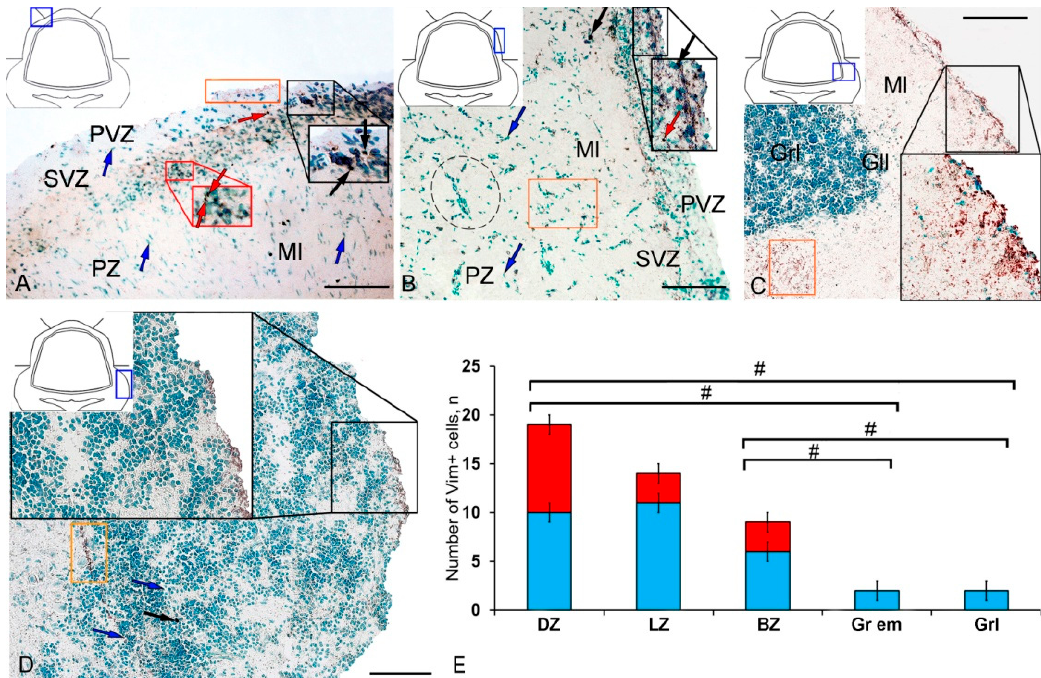
Figure 1. Distribution of vimentin in the intact cerebellum of juvenile masu salmon, Oncorhynchus masou . ( A ) Dorsal zone: Vim + cells 1 type (red arrows); Vim − cells 2 type (black arrows), aggregation of Vim + cells in the periventricular zone (PVZ) of the molecular layer (black inset); aggregation of Vim + cells in the subventricular zone (SVZ) of the molecular layer (red inset); areas of extracellular vimentin deposition are outlined by orange rectangle; molecular layer (Ml). ( B ) Lateral zone (see designations in Figure 1A): black dotted lines outline clusters of Vim − cells; subventricular zone (SVZ), parenchymal zone (PZ). ( C ) Basal zone, ganglionic layer (Gll), granular layer (Grl), and other designations as in Figure 1A. ( D ) Granular eminences. ( E ) The comparative distribution of Vim + cells in di ff erent zones of cerebellum in intact fish ( n = 5 in each group; # are significant intergroup di ff erences) One-way analysis of variance (ANOVA). Immunohistochemical (IHC) labeling of vimentin. Blue rectangle in the pictogram indicates the corresponding area in the micrograph. Scale bars: ( A – D ) 100 µ